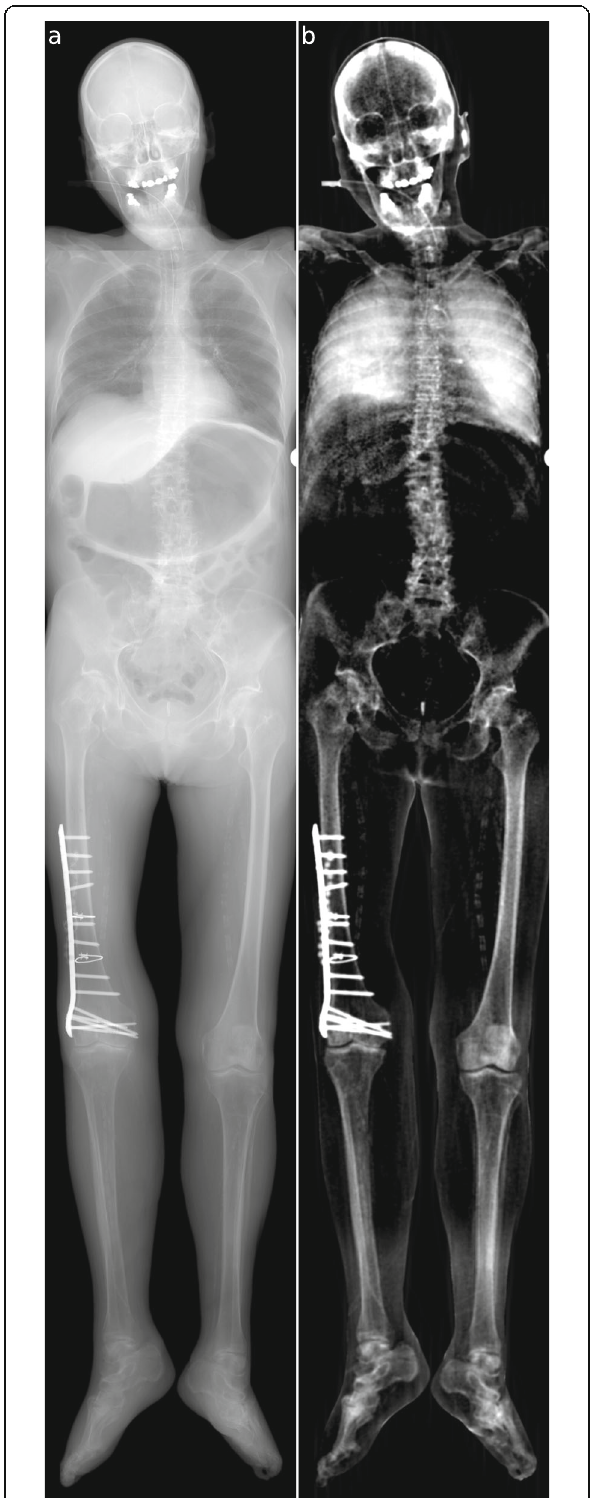
Fig. 1 Attenuation (window level 2.5, window width 5) ( a ) and x-ray dark-field (window level 0.175, window width 0.35) ( b ) radiographs of a human cadaver excluding the arms, recumbent, anteroposterior acquisition with the right hand side of the body on the left side. The images are created from six individual scans. A correction for visibility reduction due to beam hardening was